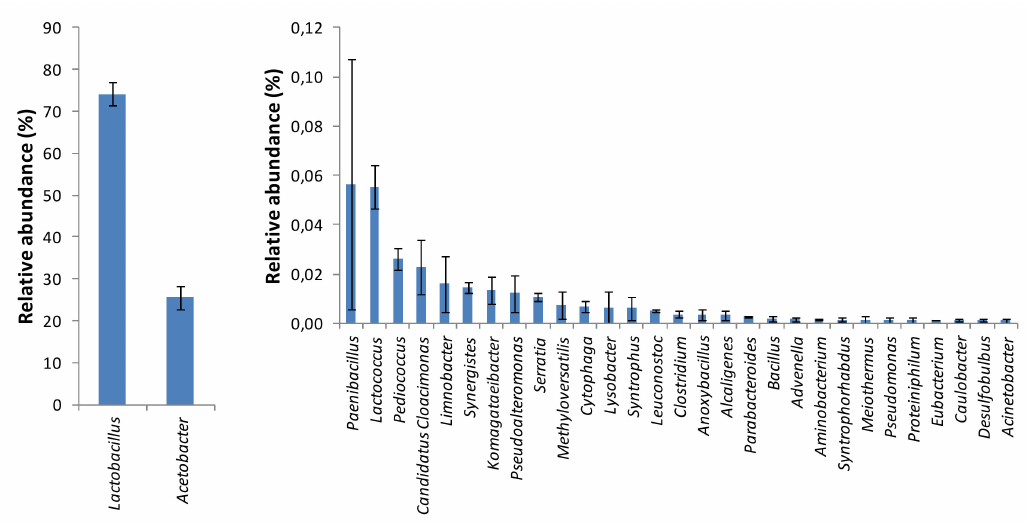
Figure 5. Bacterial diversity at genus level in the orange juice processing waste examined by Illumina assay technology.